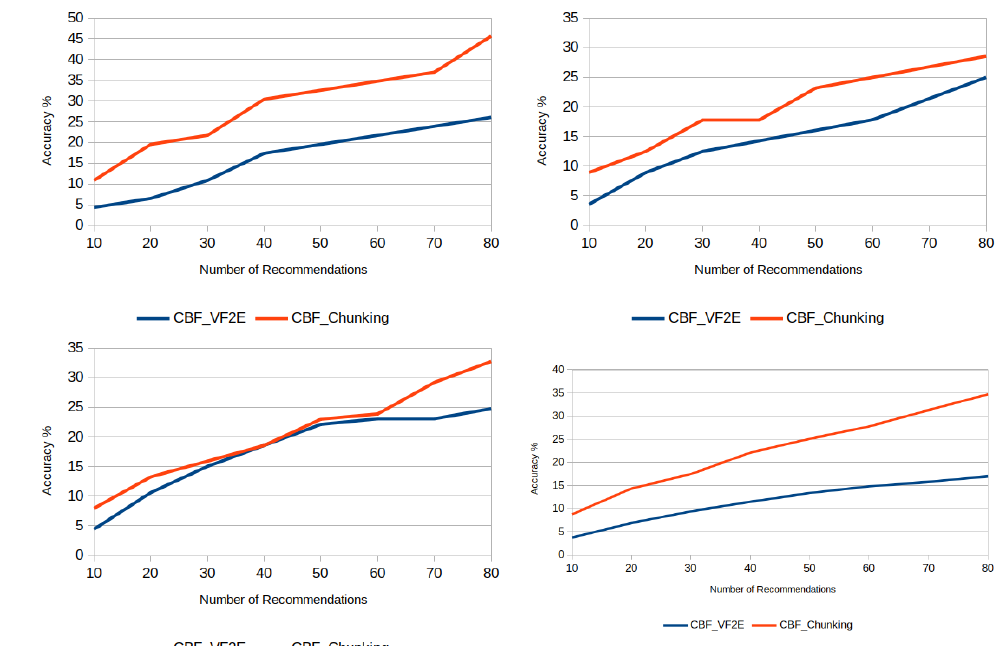
Figure 10. Performance comparison of proposed CBF_Chunking technique with baseline methods (VF2E) for a group of three users in each graph and the average results graph of these groups.